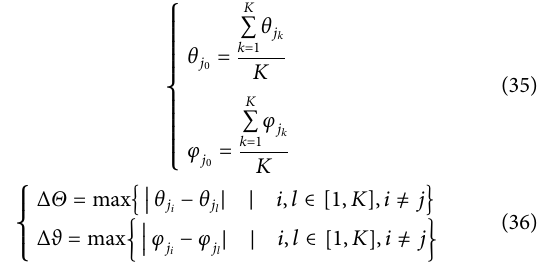
FIGURE 3 Schematic diagram of central incident direction and interference distribution.